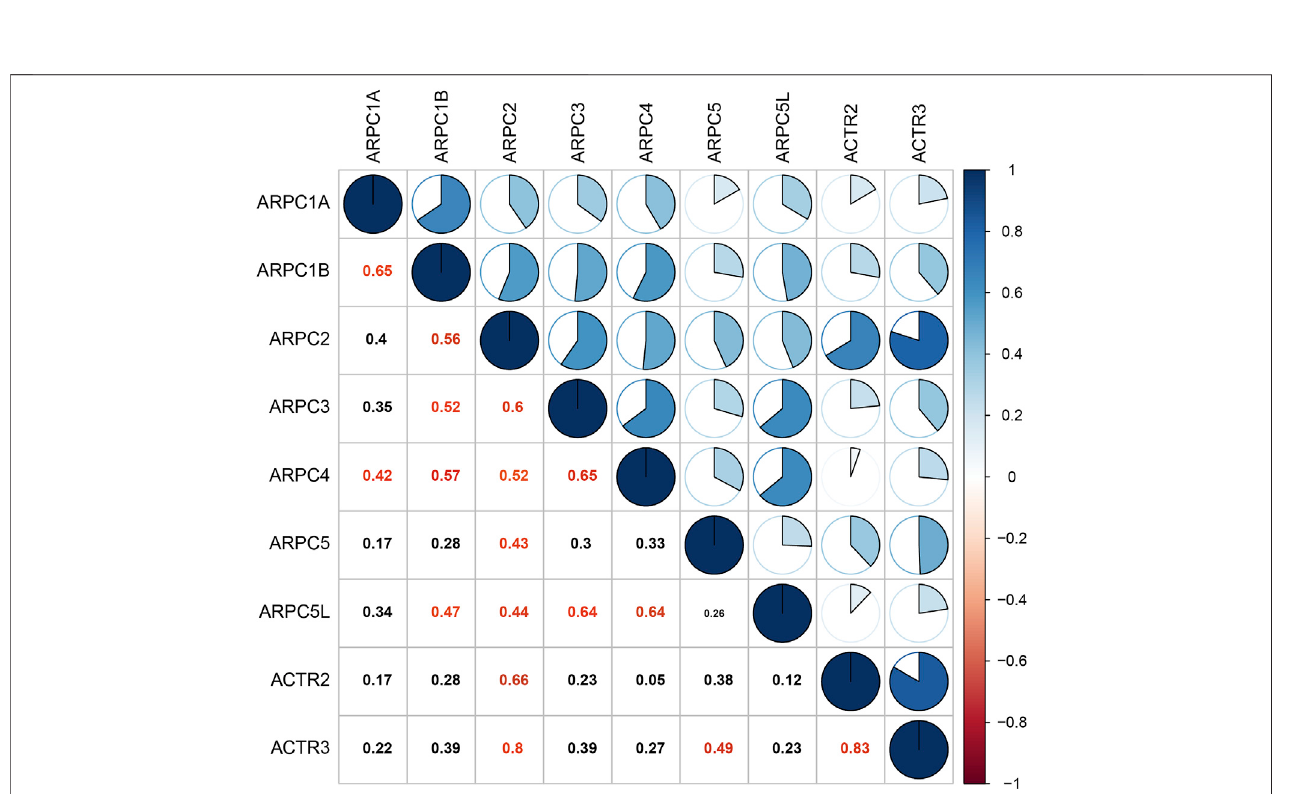
FIGURE5| CorrelationanalysisofeachArp2/3complexmember.ThedatawereanalyzedbyPearson ’ scorrelation,andPearson ’ sRcutoffvaluewas0.4.Thered values represent signi fi cant correlation between the Arp2/3 members.